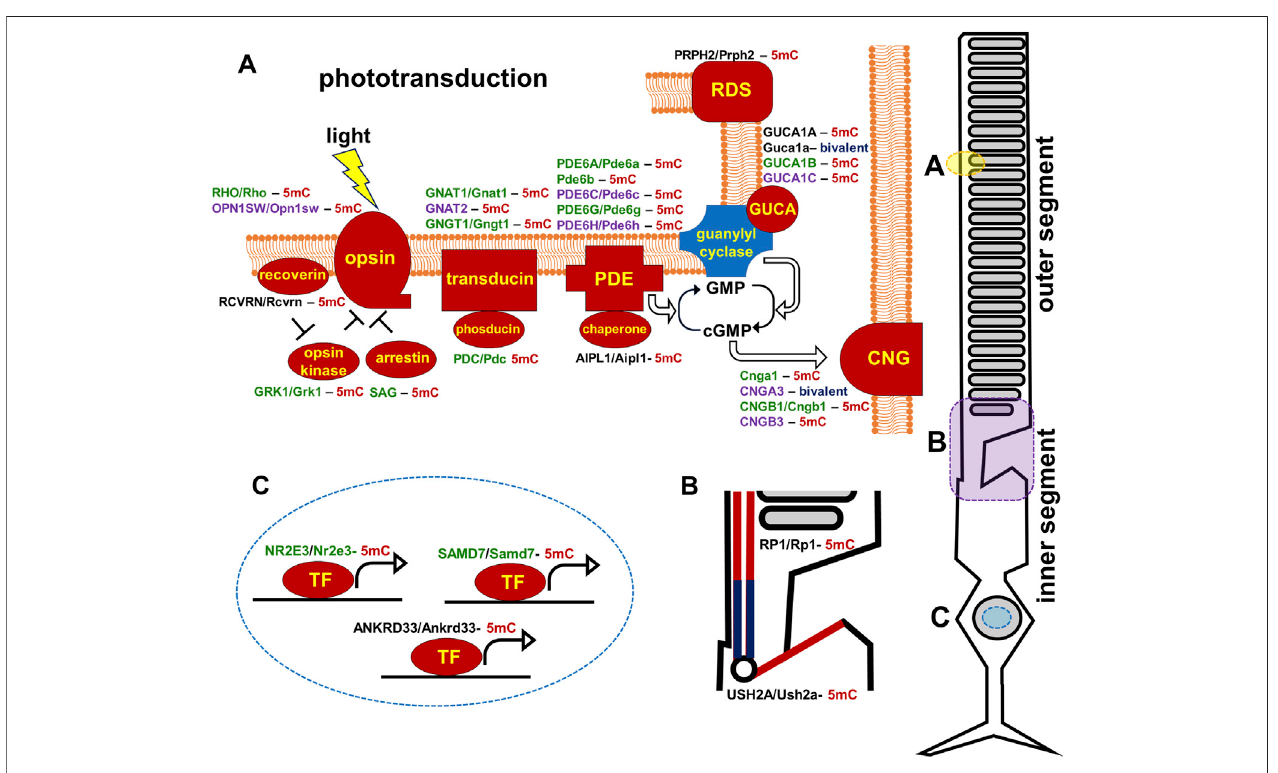
FIGURE 9 | Promoters of human and mouse genes coding molecular components of the photoreceptor outer segment (phototransduction cascade) and inner segmentaremostlyhypermethylatedinembryonicretinas/RPCs(thecorrespondingproteinsaremarkedinred).Thegenesarecoloredgreenforrods,purpleforcones, and black indicates expression in both rods and cones. (5mC- 5-methylcytosine, gene with hypermethylated promoter; bivalent-bivalent